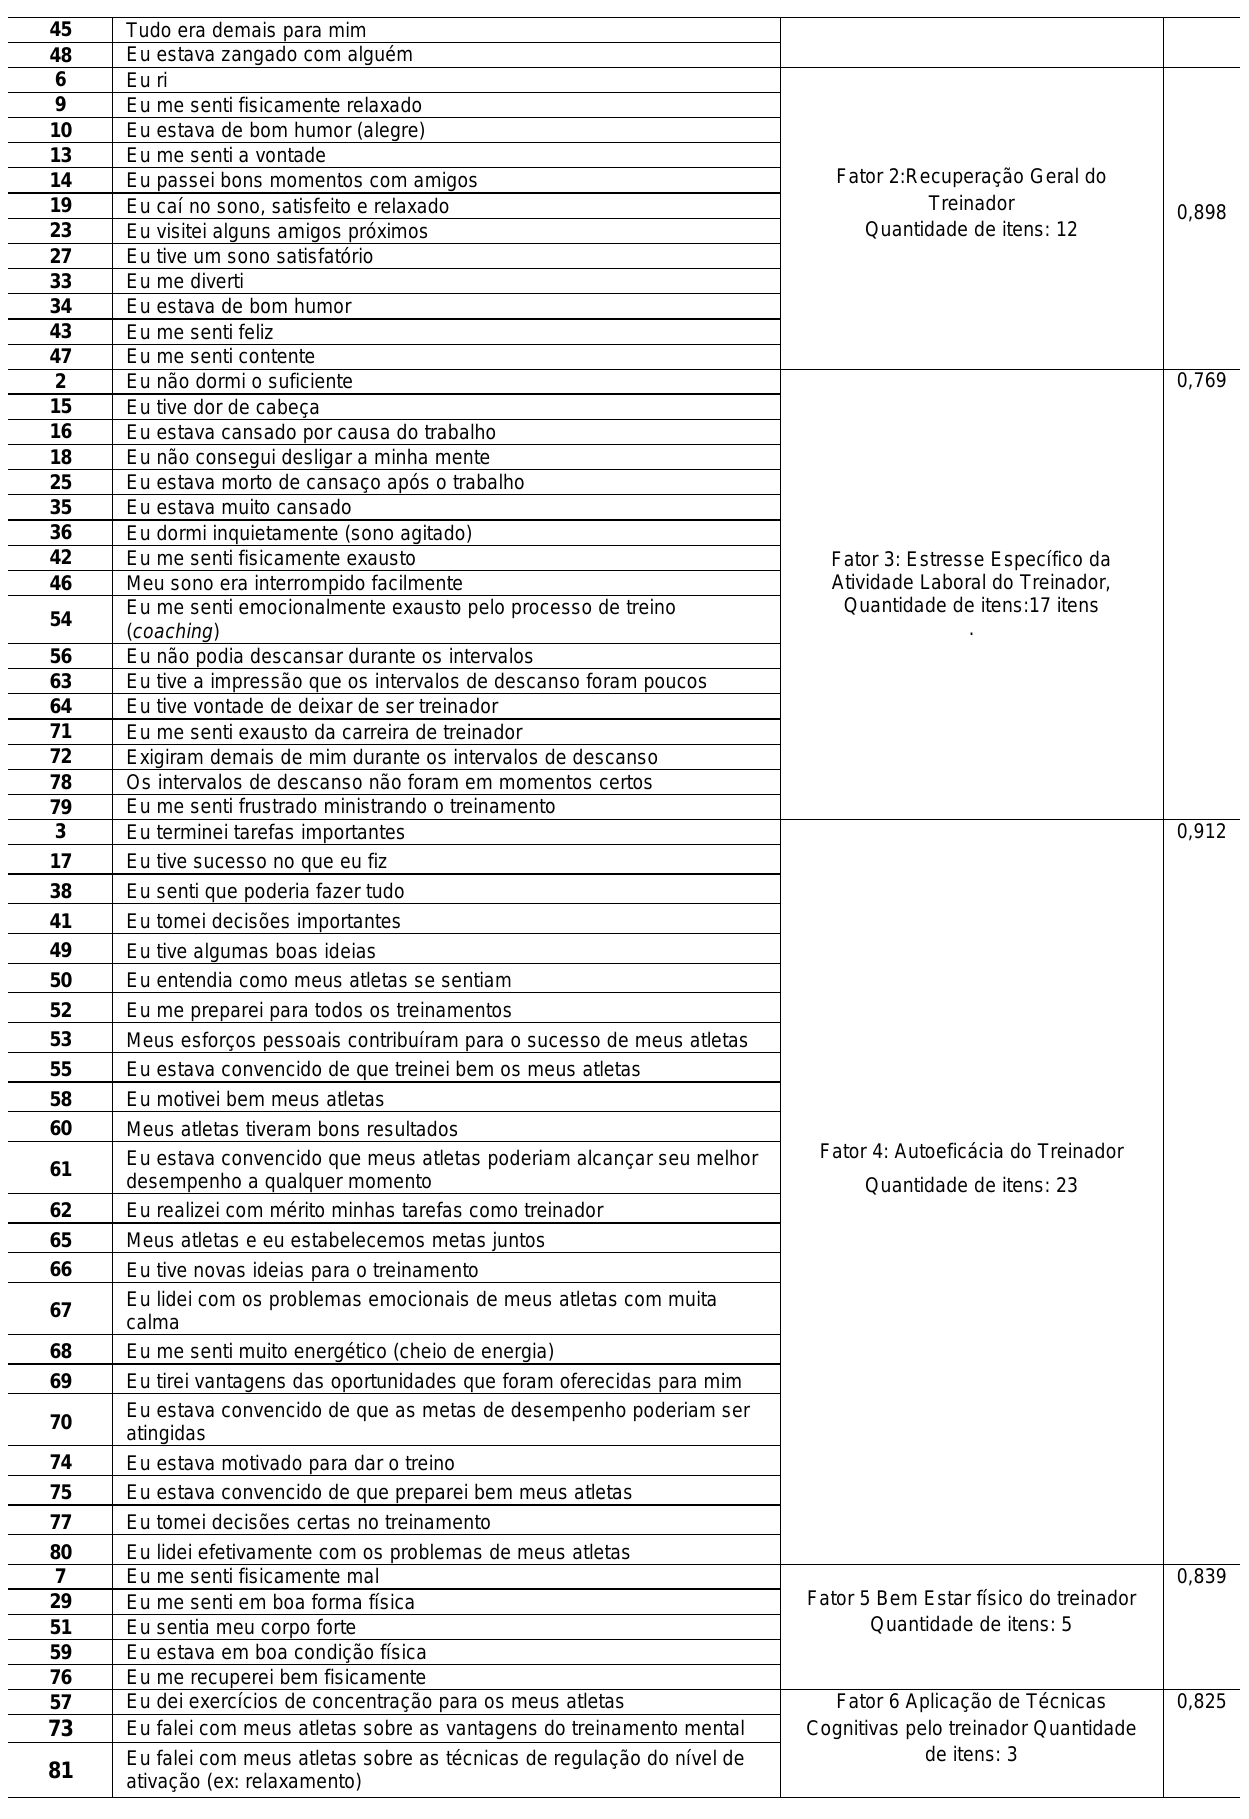
Fator 3: Estresse Específico da Atividade Laboral do Treinador, Quantidade de itens:17 itens .